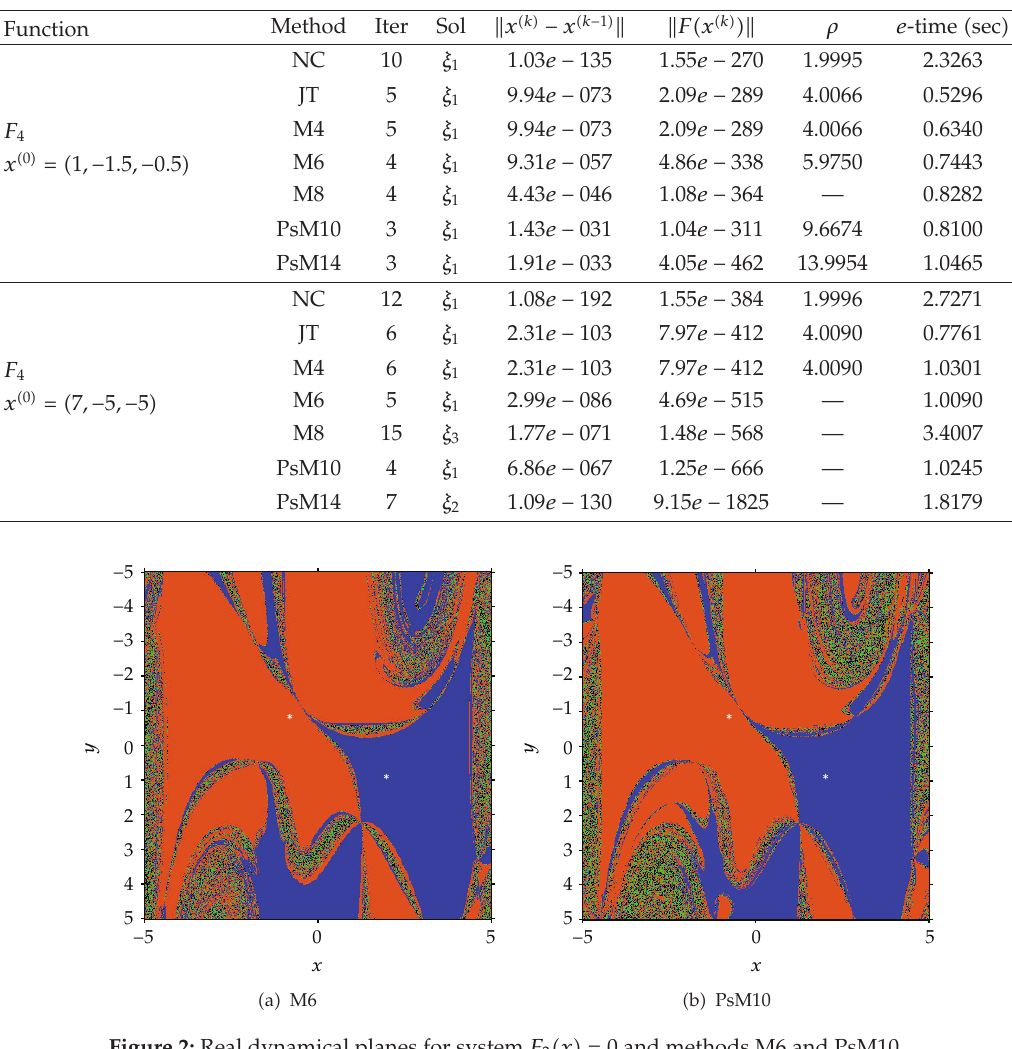
Figure 2: Real dynamical planes for system F 2 (cid:4) x (cid:5) (cid:6) 0 and methods M6 and